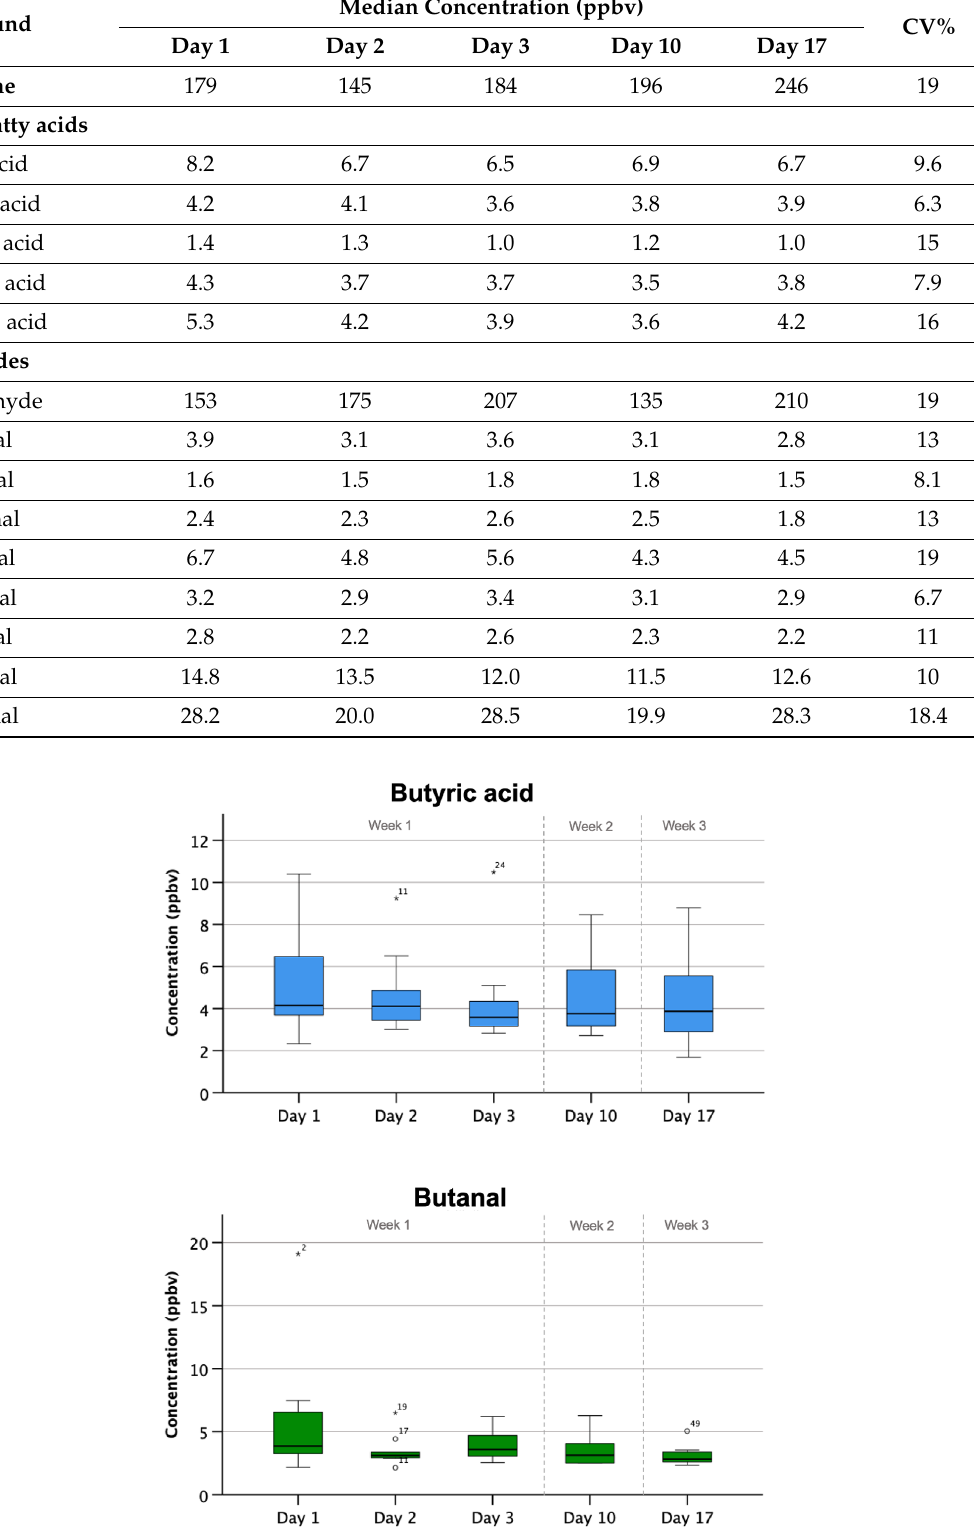
Figure 2. Longitudinal variation of the concentrations (ppbv) of butyric acid and butanal in saliva. Circles and asterisks denote outlying